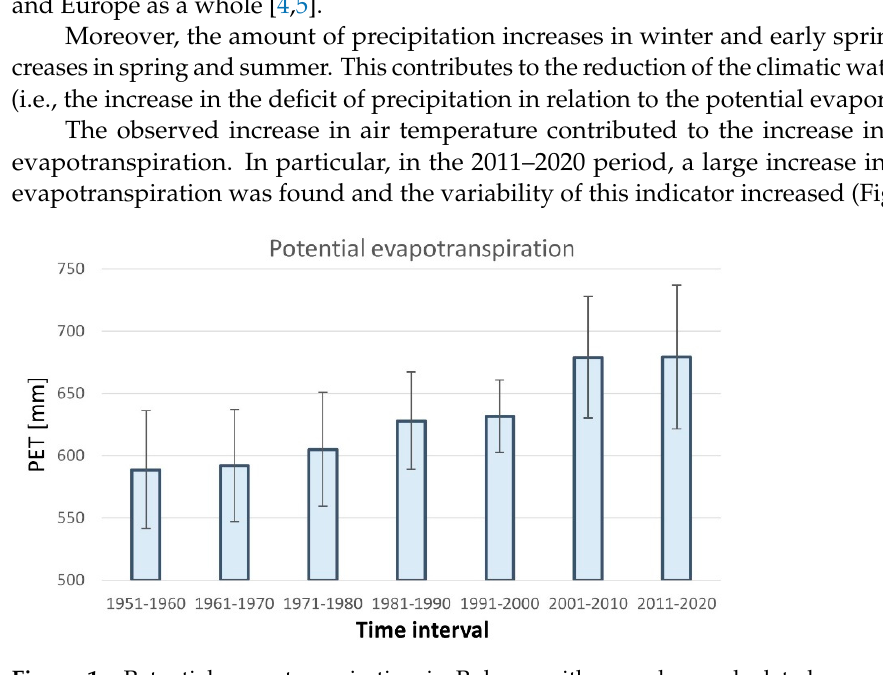
Figure 1. Potential evapotranspiration in Pulawy with error bars calculated according to the Doroszewski formula [6].